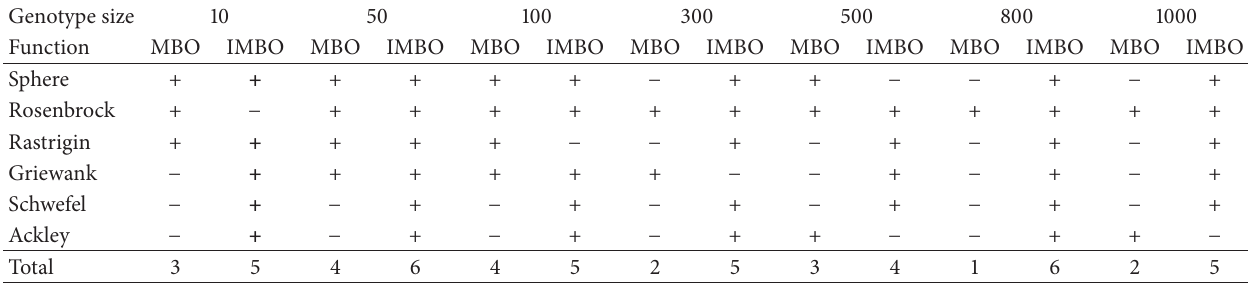
Table 4: Success rates of MBO when compared with those of the IMBO algorithm. + indicates that the algorithm is better while − indicates that it is worse than the other. If both algorithms show similar performance, they are both +.